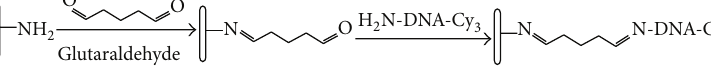
Scheme 1: Aldehyde modification of glass slide.